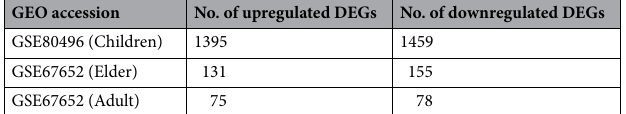
Table 1. Total number of up and downregulated DEGs in all three age